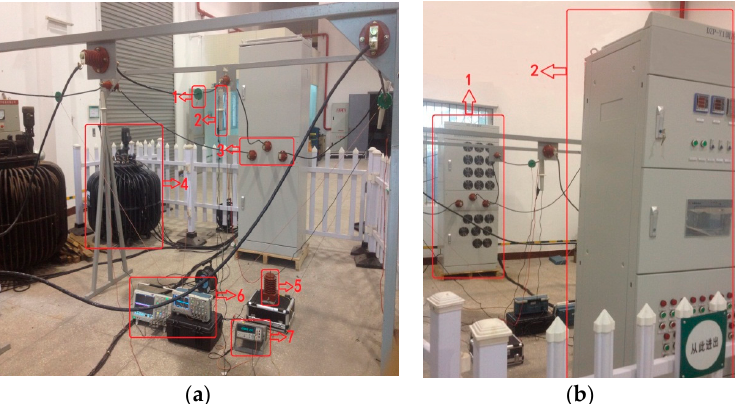
Figure 19. Experimental platform structure: ( a ) experimental platform structure 1; and ( b ) experimental platform structure